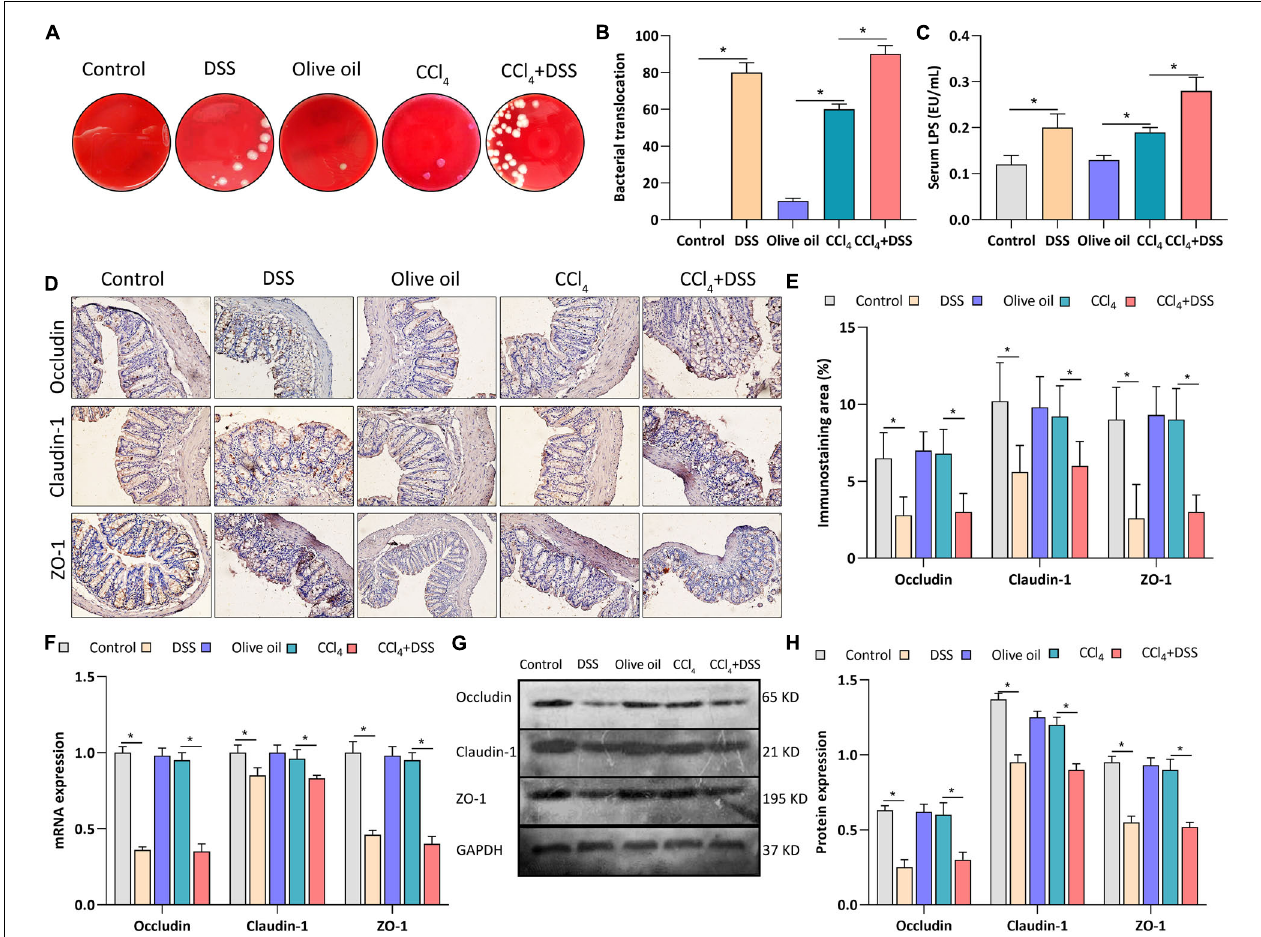
FIGURE 3 | DSS-induced colitis regulated gut barrier function in CCl4-induced liver fibrosis mice. (A) Representative images of bacterial translocation assay and (B) quantitative analysis of the bacterial translocation to MLN were shown; (C) Serum lipopolysaccharide (LPS) levels; (D) Representative images of IHC staining colon sections (magnifications × 400) and (E) staining intensity of tight junction proteins were shown; (F–H) Expression levels of tight junction proteins in colon were measured by qRT-PCR (F) and western blot (G,H) . Data were expressed as mean ± SD. *, p < 0.05.